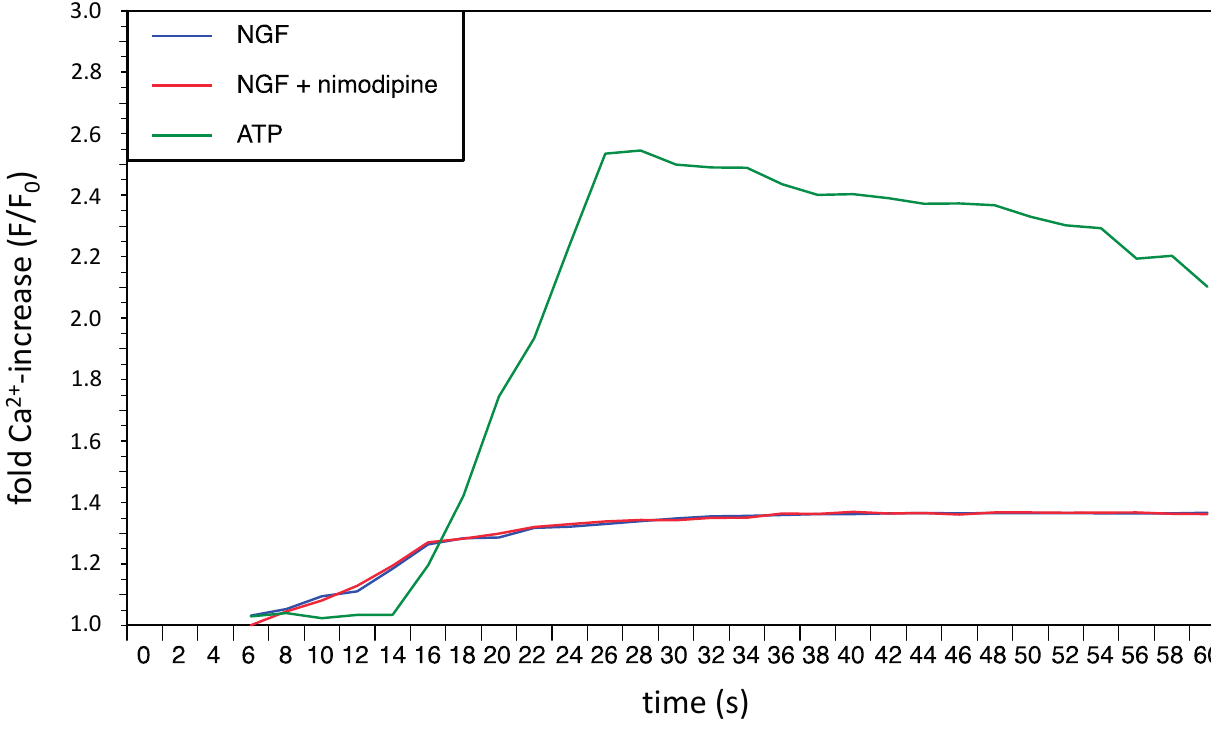
Figure 7. Fold Ca 2+ -increase (F/F 0 ) in PC12 cells after stimulus with NGF (100 ng/mL) alone or NGF (100 ng/mL) in combination with nimodipine ( 2 µ M) . ATP (150 µM) was used as a positive control for intracellular calcium